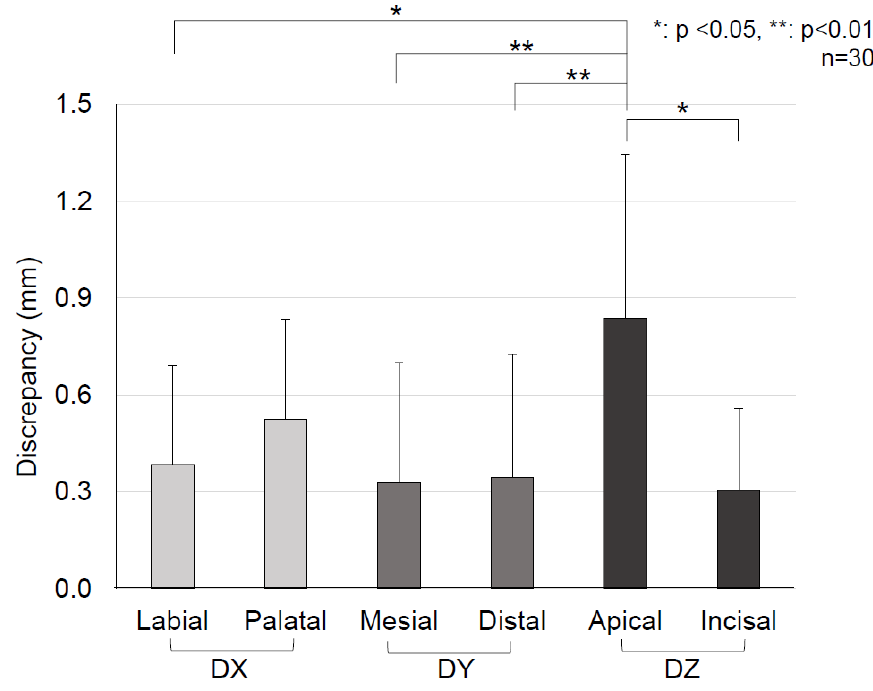
Figure 5. Comparison of the average discrepancy of each X, Y, and Z axis and six directions based on one–way ANOVA and Turkey’s post-hoc test. The discrepancy on the Z axis in the apical direction (intrusion direction) was significantly greater than that observed for all other directions ( p < 0.05). Table 2. The average root displacement of each tooth type on the X, Y, and Z axes and in six direc- tions. There was no significant difference among the three tooth types.